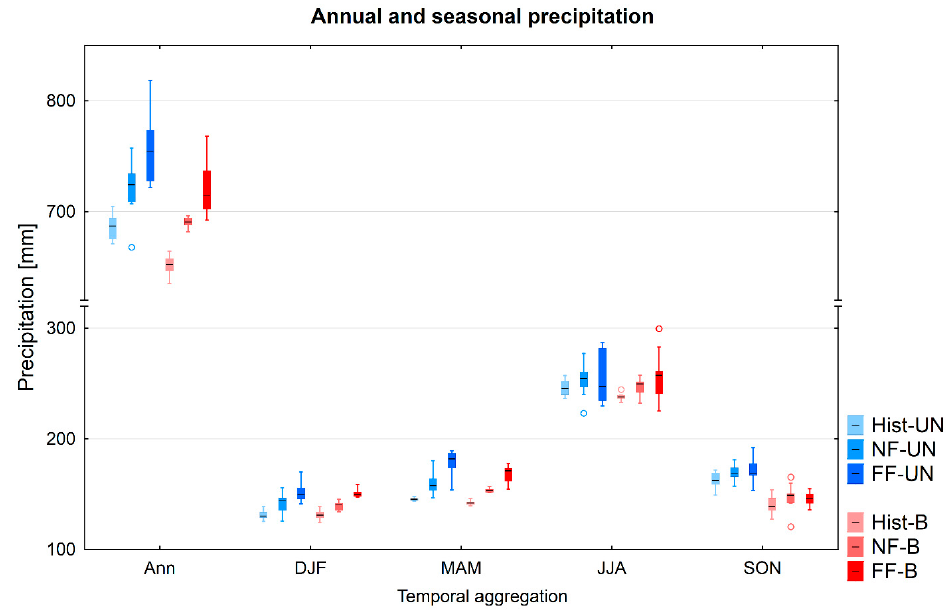
Figure 5. Multi-model ensemble projections of annual and seasonal precipitation for the near (NF) and the far (FF) future under RCP 4.5 in comparison to the historical (Hist) period. B stands for the Barycz catchment and UN stands for the Upper Narew catchment.